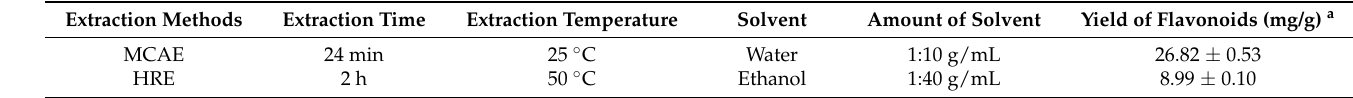
Table 1. Comparison of MCAE with HRE methods.